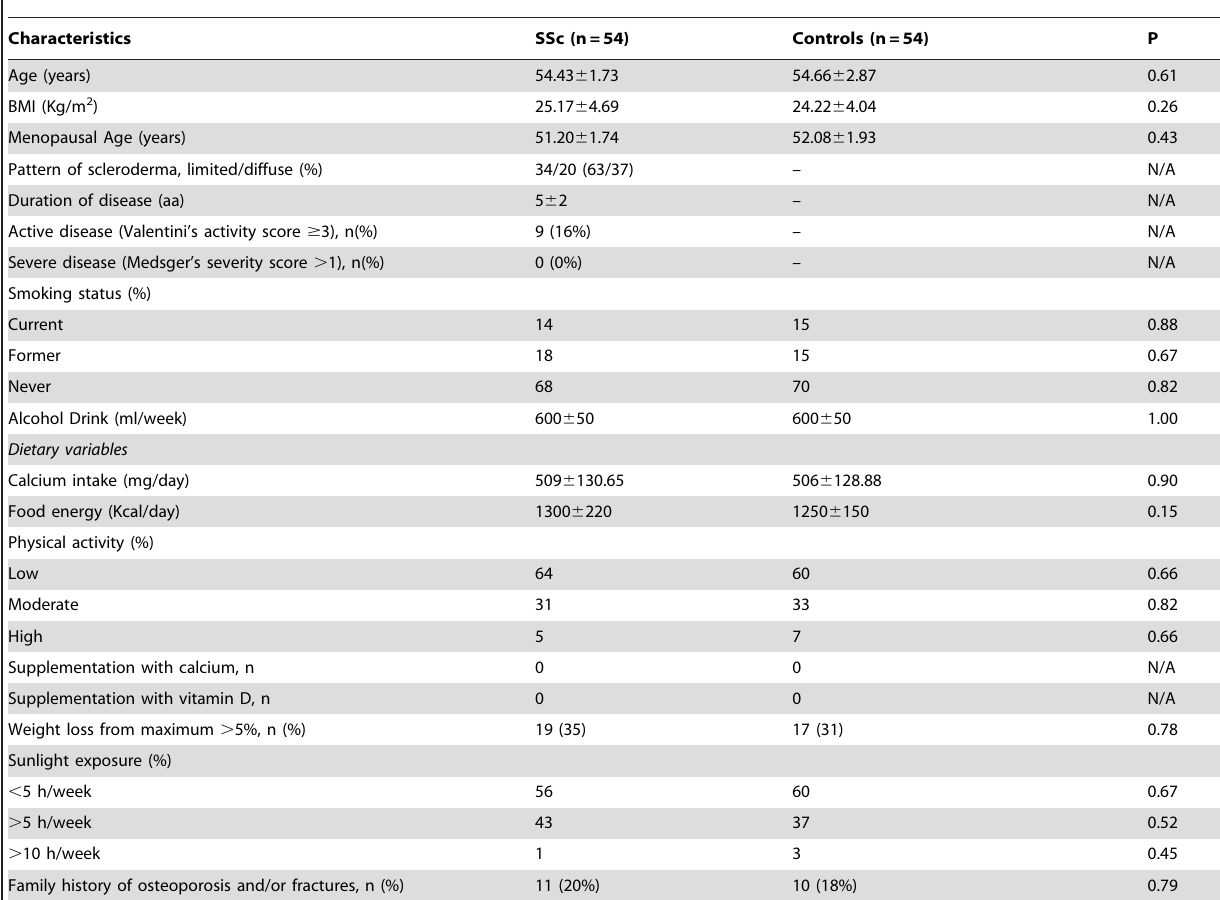
Table 1. Characteristics of patients in two groups. a